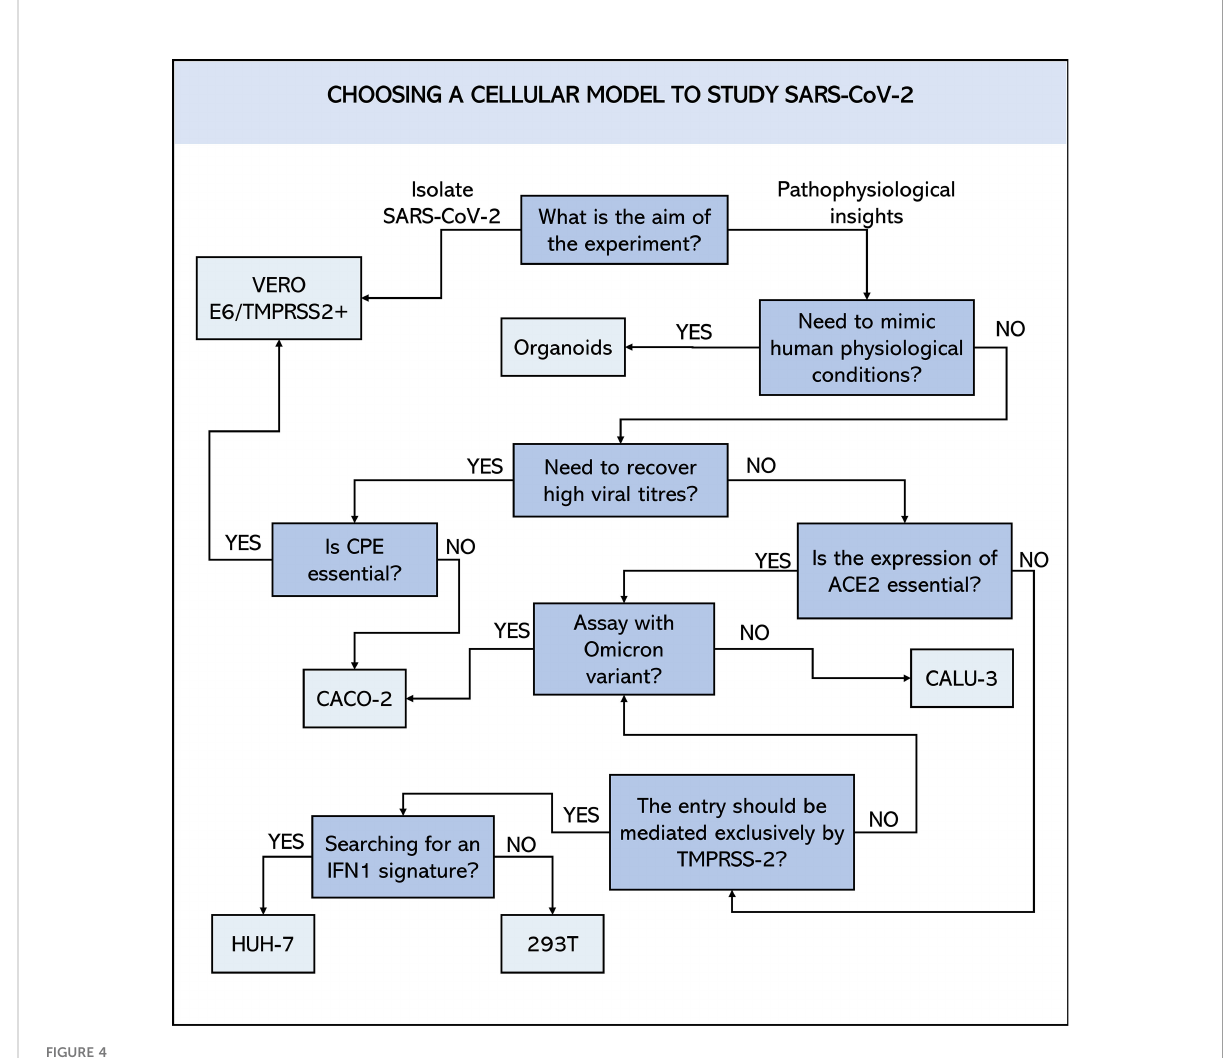
FIGURE 4 Schematic representation of a decision fl owchart to choose which cell line to employ in SARS-CoV-2 studies. ACE2, angiotensin-converting enzyme 2 receptor; CPE, cytopathic effect; TMPRSS2, transmembrane protease serine 2; IFN1, Interferon type